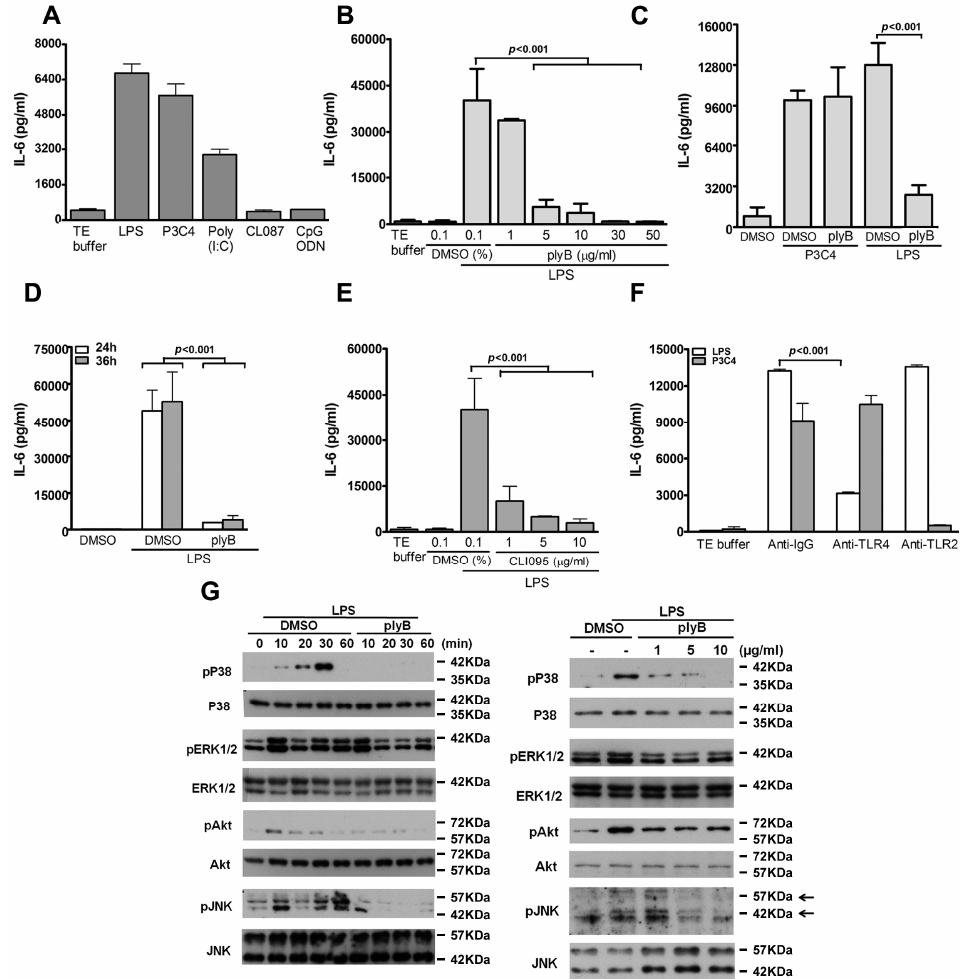
Figure 1. Activation of TLR4 signaling in vascular smooth muscle cells (VSMCs) induces